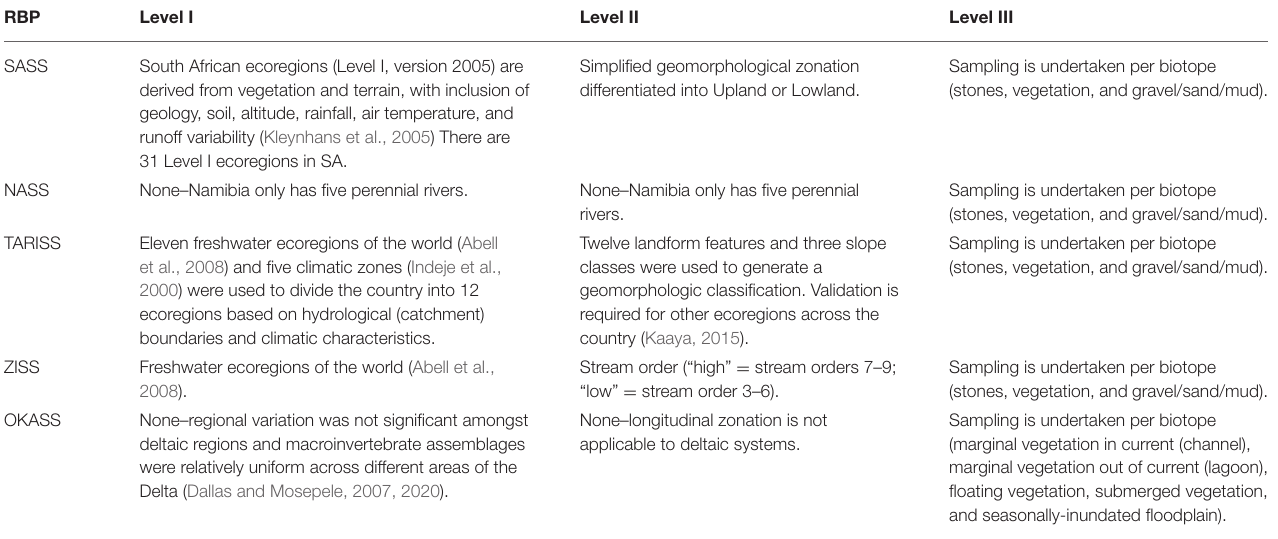
TABLE 3 | Hierarchical spatial frameworks for Rapid Bioassessment Protocols (RBP) currently used in Africa, including the South African Scoring System (SASS, Dickens and Graham, 2002), Namibian Scoring System (NASS, Palmer and Taylor, 2004), Tanzania River Scoring System (TARISS, Kaaya et al., 2015) and Zambian Invertebrate Scoring System (ZISS, Dallas et al., 2018), and Okavango Assessment System (OKASS, Dallas,